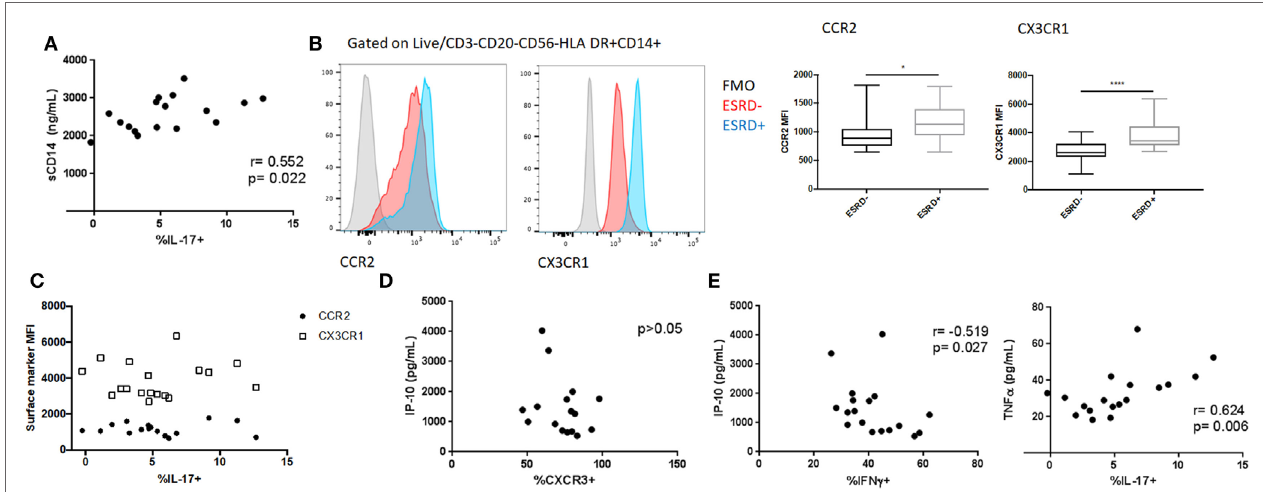
FigUre 7 | Relationship between inflammatory biomarkers and mucosal-associated invariant T (MAIT) cell (CD4 − V α 7.2 + CD161 ++ ) phenotype and function. (a) Correlation between PMA/ionomycin-induced MAIT IL-17 production and systemic sCD14 levels among end-stage renal disease (ESRD) participants. (B) Analysis of CCR2 ( n = 16 ESRD − , n = 17 ESRD) and CX3CR1 ( n = 20 per group) surface density on monocytes (defined as Live, CD3 − CD20 − CD56 − HLA DR + CD14 + cells) among control and ESRD groups. (c) Correlation between monocyte phenotype and PMA/ionomycin-induced IL-17. (D) Correlation between MAIT cell CXCR3 expression and plasma IP-10 concentration among ESRD participants. (e) Correlation between PMA/ionomycin-induced IFN γ or IL-17 production and plasma cytokines among ESRD participants. Correlations performed by Spearman test. Comparisons performed by Mann–Whitney test, * p < 0.05, ** p <